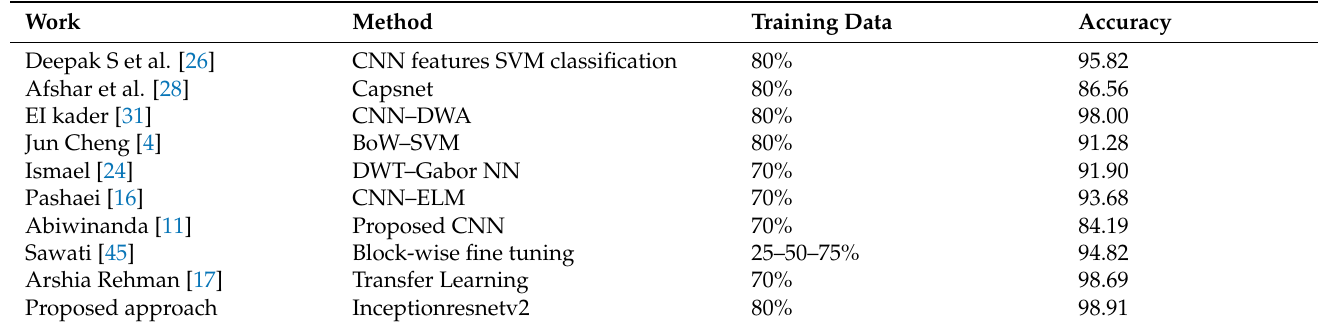
Table 5. Comparison with existing